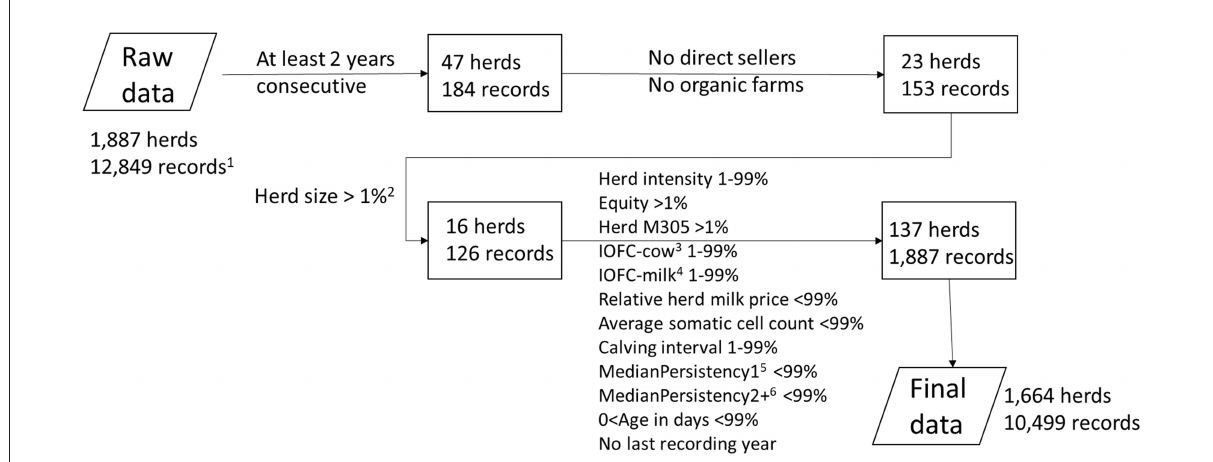
FIGURE2 Diagram on data editing of the combined production and accounting dataset. The numbers in the boxes represent the excluded numbers. 1 yearly records. 2 %: percentile. 3 IOFC-cow: income over feed cost per cow. 4 IOFC-milk: income over feed cost per 100kg milk. 5 1: for primiparous cows. 6 2 + : for multiparous